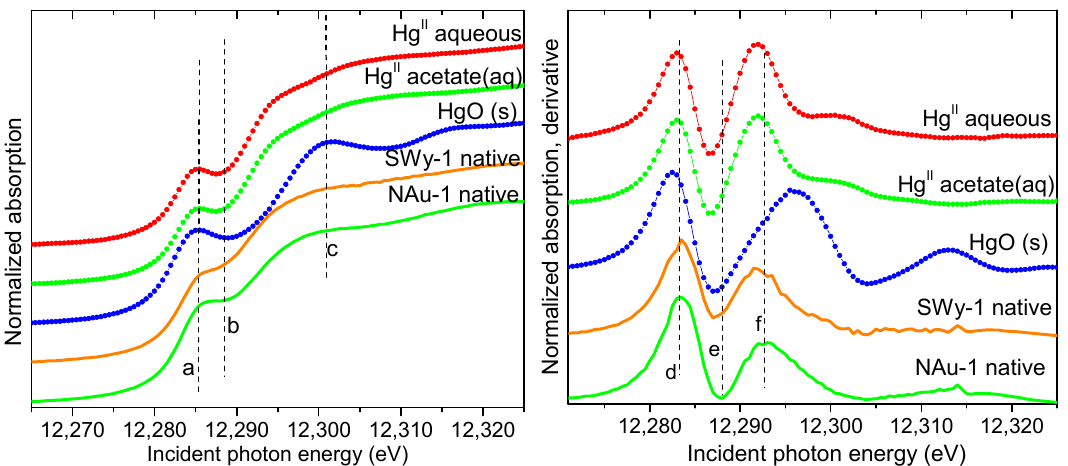
Figure 2. Hg L III -edge XANES spectra ( left ) and derivative ( right ) obtained from the solid phase in the systems with native NAu-1 and SWy-2 clays. The spectra are compared to aqueous and solid Hg(II) standards (symbols), which exhibit a deep dip and the large second peak in the derivative spectra (features e and f). The vertical dashed lines (a–f) are a guide to the eye.